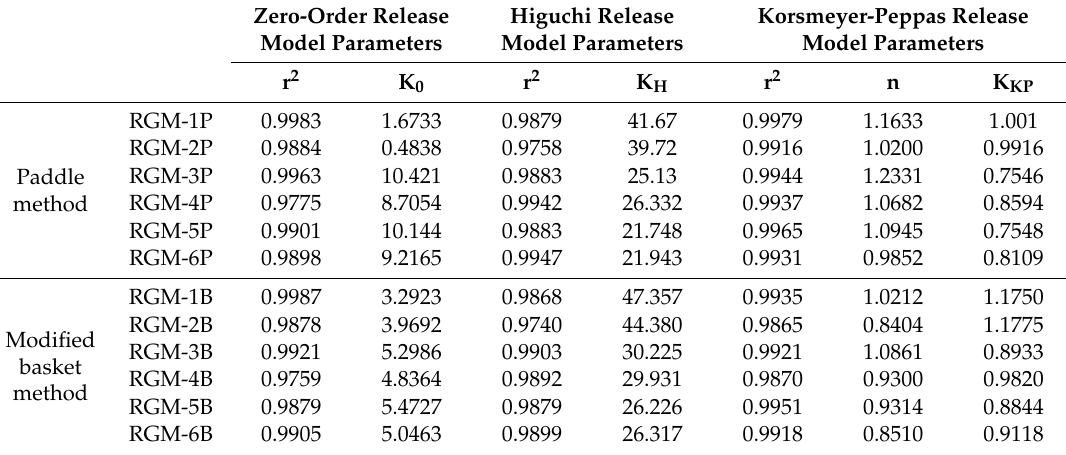
Table 4. Kinetic data for prepared